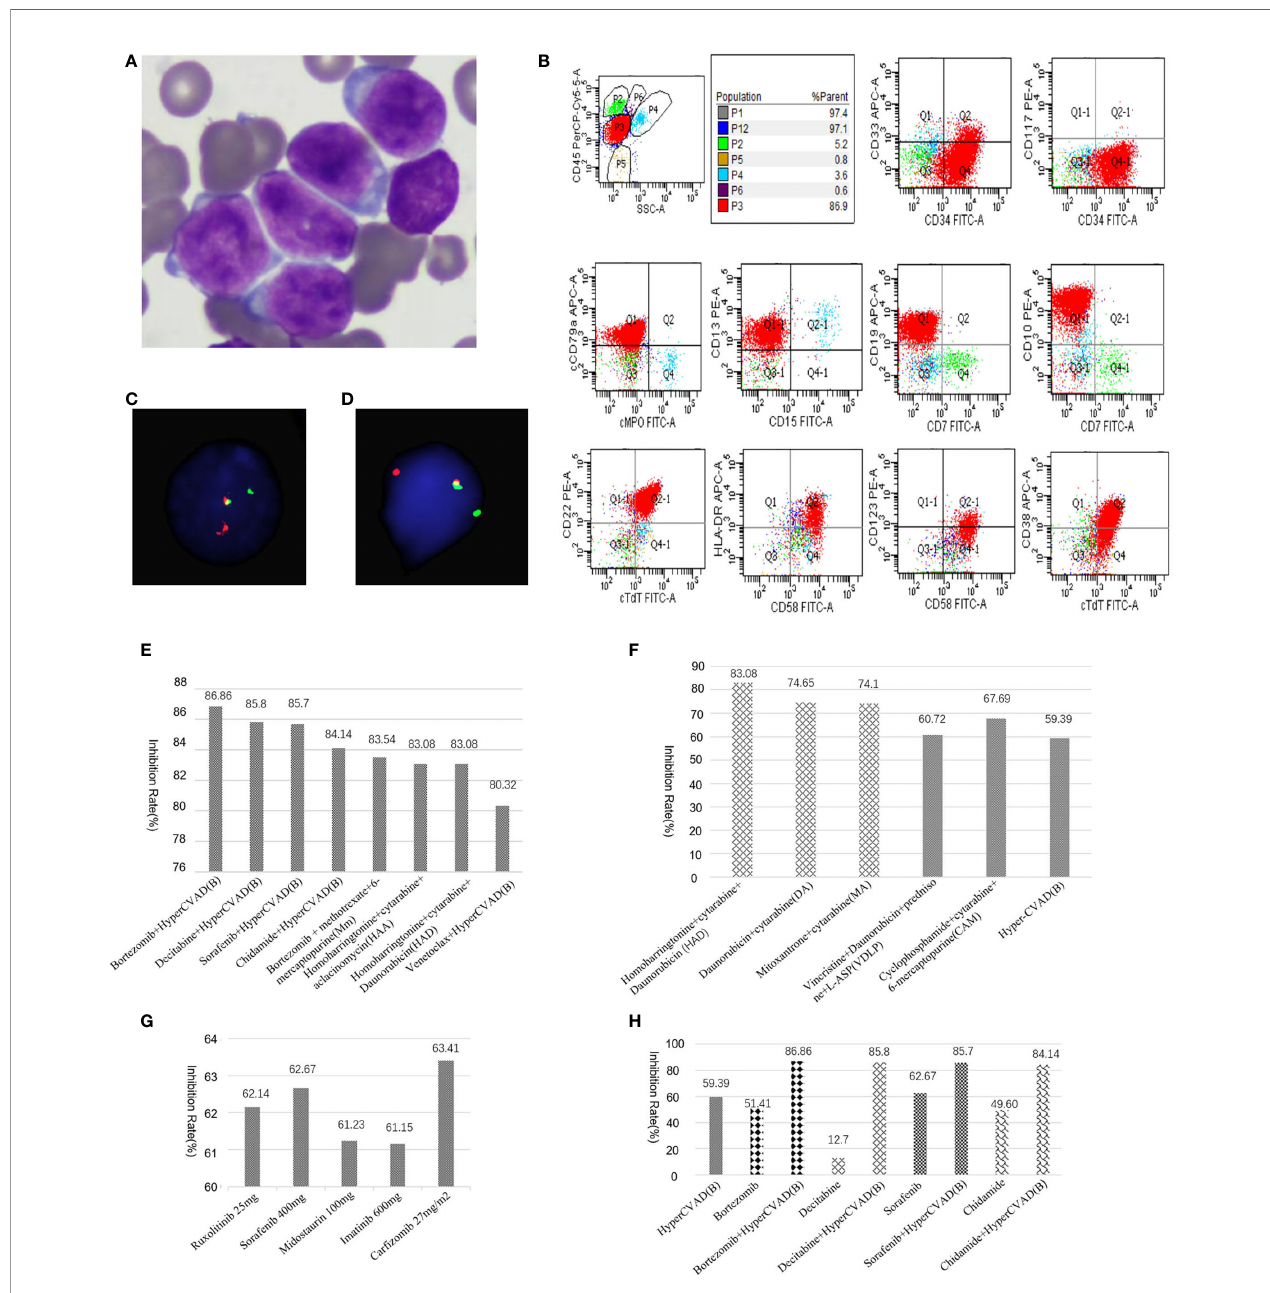
FIGURE 1 | (A) Morphology of lymphoblasts at diagnosis (original magni fi cation, × 1000). (B) Flow cytometry result. (C) FISH results using a break-apart probe for TCF3. Rearrangement of TCF3 was shown as one red and one green signal. (D) FISH results using a break-apart probe for ZNF384. (E) Drug sensitivity screening test in vitro with a panel of 156 kinds of cytotoxic drugs, molecular targeted therapy drugs, and combination chemotherapy regimens. Relative inhibition rates higher than 80% were listed. (F) Relapsed lymphoblasts showed moderate sensitivity to both an ALL scheme [VDLP, CAM, hyper-CVAD (B) ] and AML schemes (HAD, DA, MA). (G) Relapsed lymphoblasts were sensitive to multiple targeted therapeutic drugs. (H) The hyper- CVAD (B) scheme showed multiple synergistic effects with multiple targeted